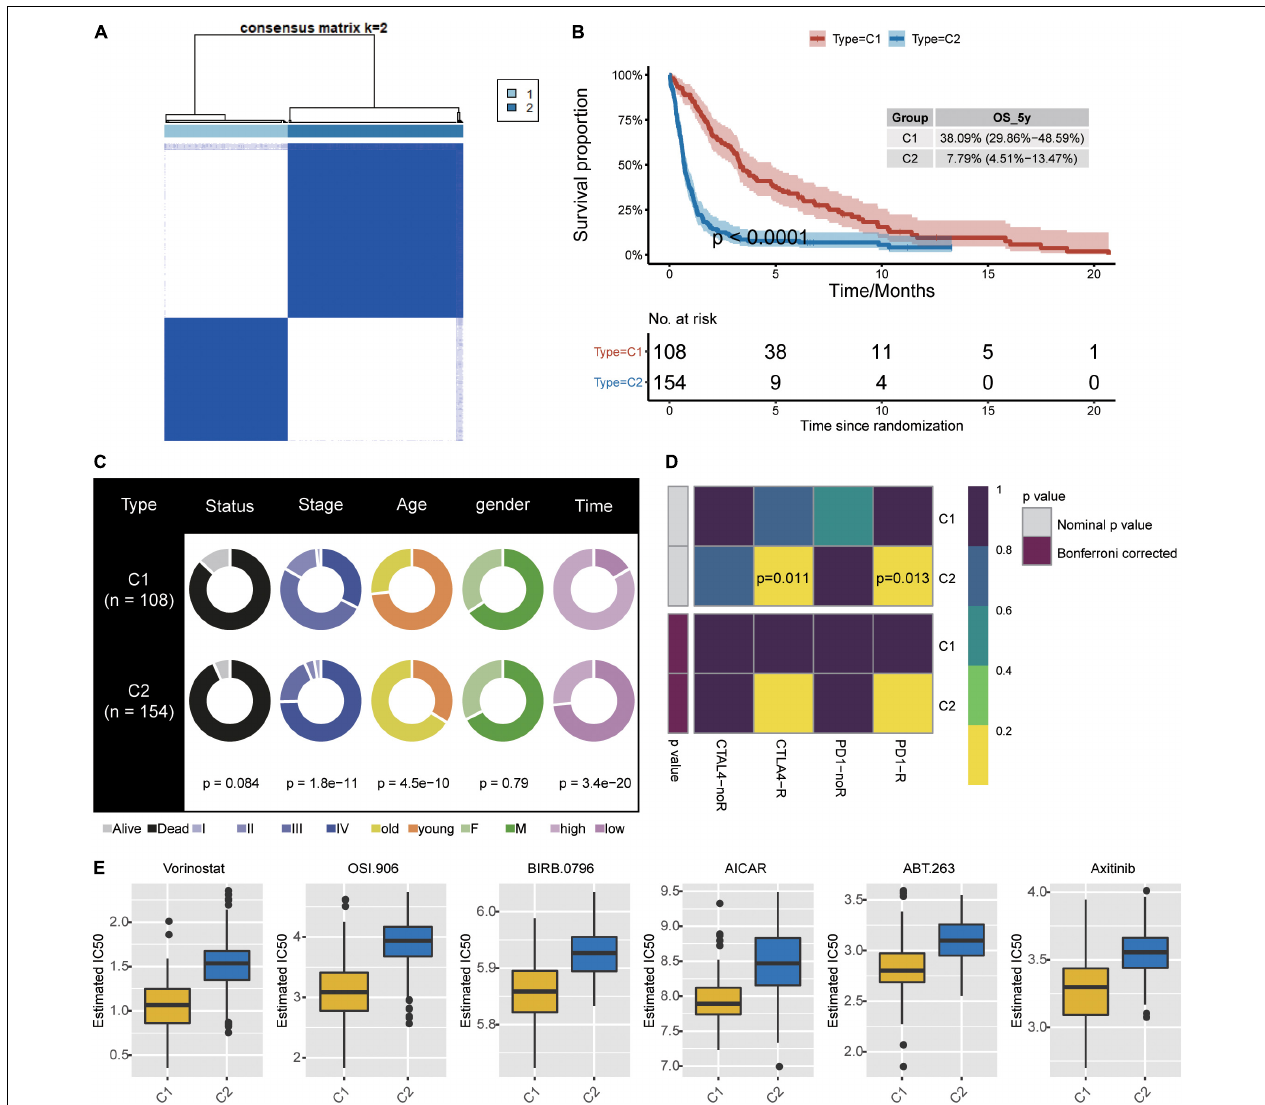
FIGURE 6 | Identification of new subtypes of GBM. (A) Consistency clustering based on six candidate genes and GBM patients, generating clusters C1 and C2. (B) Kaplan–Meier overall survival (OS) curves for the two clusters. (C) Differences in clinical characteristics between the two clusters. (D) Differences in predicted response to immunotherapy between the two clusters. (E) Predicted drug IC 50 values that differed the most between the two